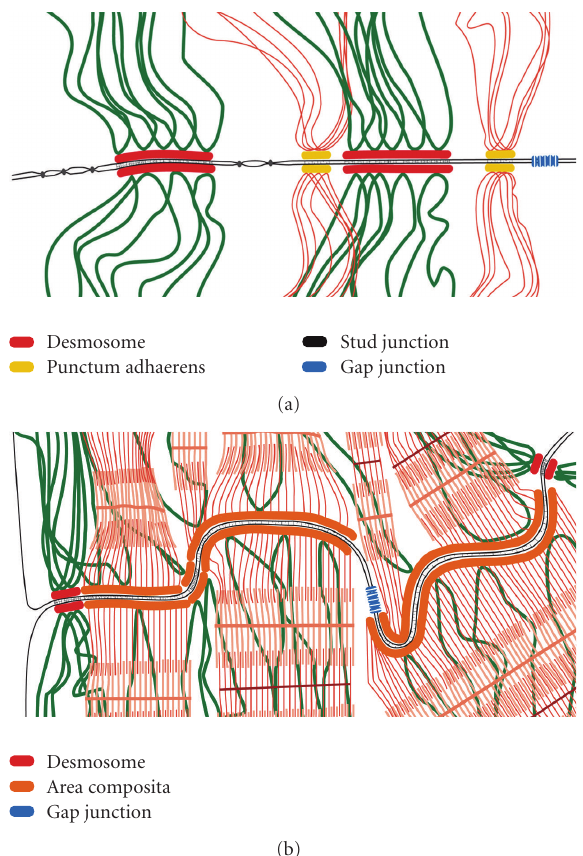
ff erent principles of organization of cell-cell junctions containing desmosomal proteins in mammalian epidermal and myocardiac tissue. (a) Junction orga- nizations between epidermal keratinocytes as observed in the stra- tum spinosum . Note the densely spaced desmosomes (red plaques), which anchor bundles of intermediate sized filaments contain- ing keratins (dark-green). Smaller adherens junctions ( puncta adhaerentia , yellow plaques) anchor actin-microfilament bundles (red filaments). Furthermore, special types of tight junction-like structures, the small “stud junctions” (black dots), and channel- like connexin paracrystals (gap junctions, blue) are also generally found. For details see [29, 30]. (b) The area composita (composite junction, orange) structures of intercalated disks (ID) connecting cardiomyocytes of an adult mammalian heart. This amalgamated type of adhering junction is characterized by a mixture of typical desmosomal and AJ molecules. This kind of composite junction is the predominating adhering junction structure in the ID of the adult mammalian